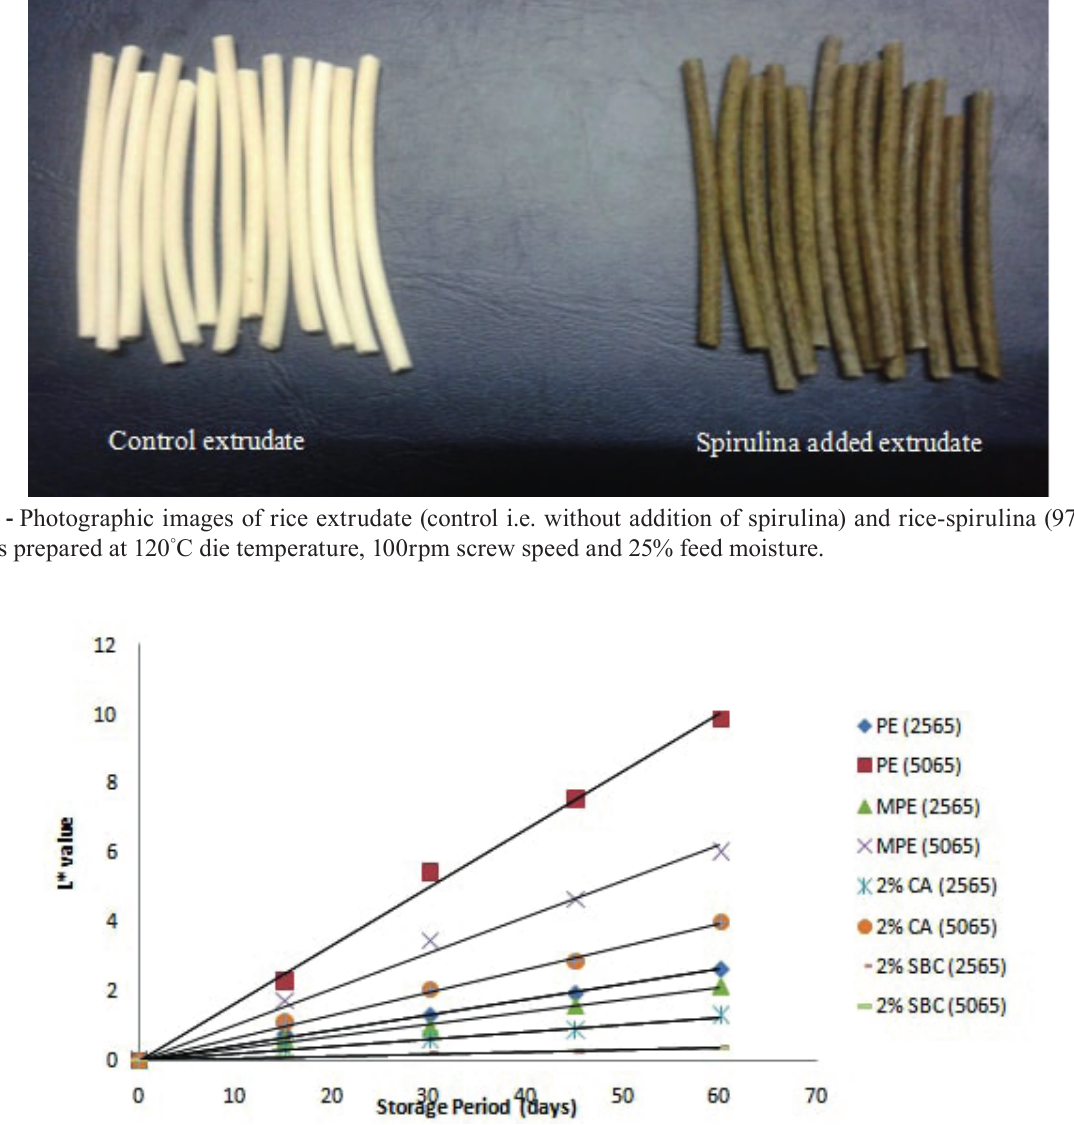
FIGURE 2 - Kinetics of colour (L*) degradation of rice extrudates prepared with and without incorporation of additives (citric acid and sodium bicarbonate at concentration of 2% each) packed and stored in different conditions (25°C and 50°C with 65% relative humidity) as a function of storage time for zero order